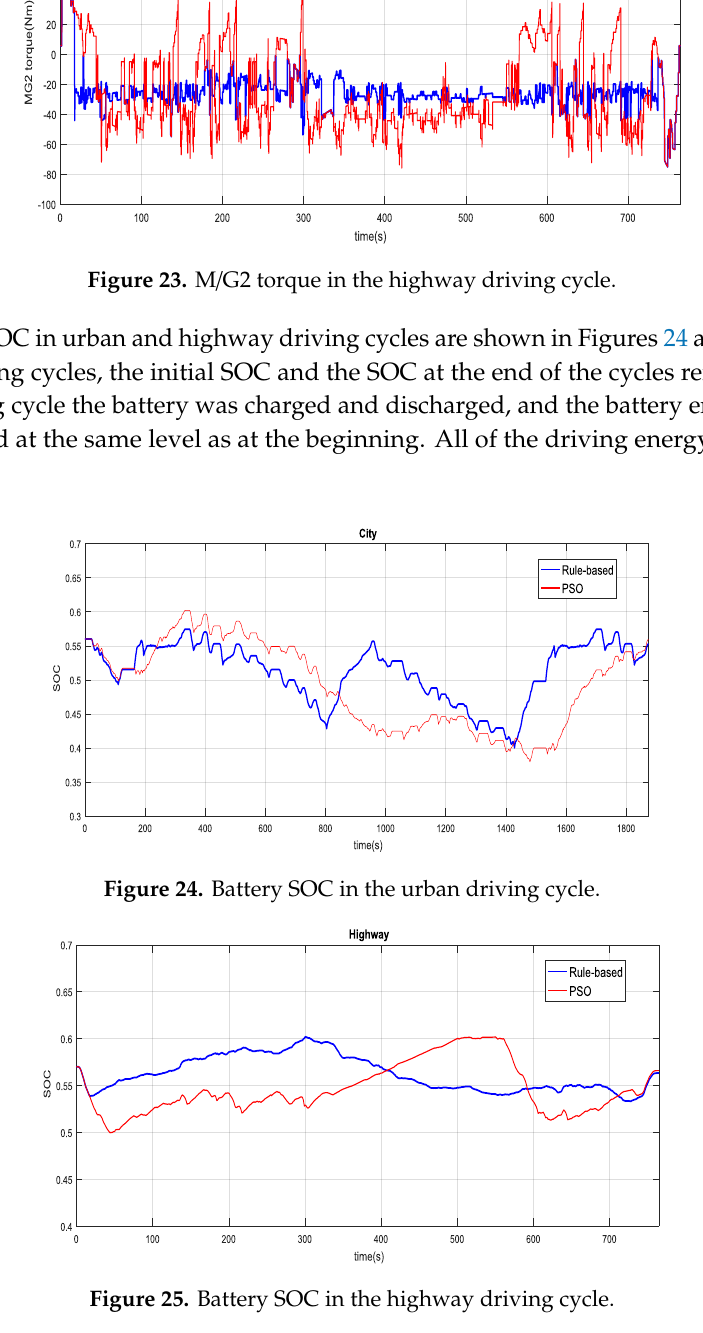
Figure 22. M/G2 torque in the urban driving cycle.